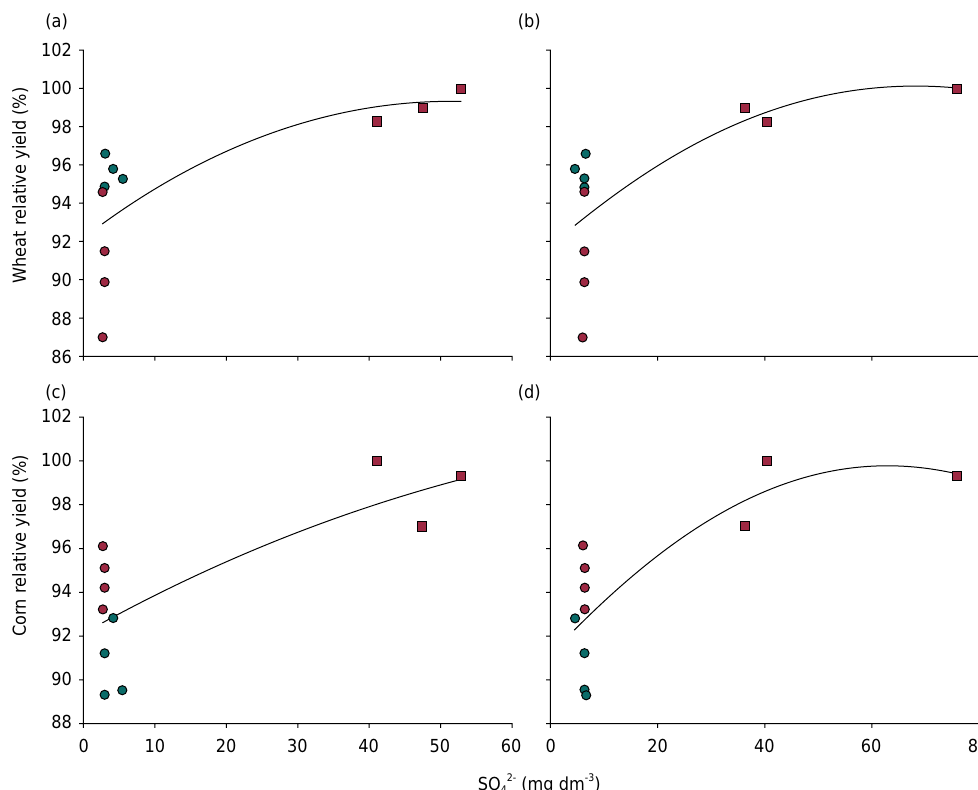
Figure 9. Relationship between sulfate content (S-SO 42- ) in 0.00-0.20 (a, c) and 0.20-0.60 m (b, d) soil layers and relative yield of wheat and corn in response to incorporated ( ) or surface lime ( ) or to surface lime combined with phosphogypsum application ( ). The relative grain yields were calculated by dividing the yields by the maximum yield in each